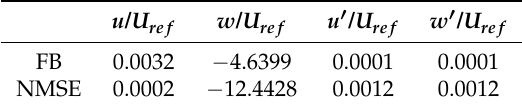
Table A3. FB and NMSE between experiment and simulation for the case with a wind catcher in Section